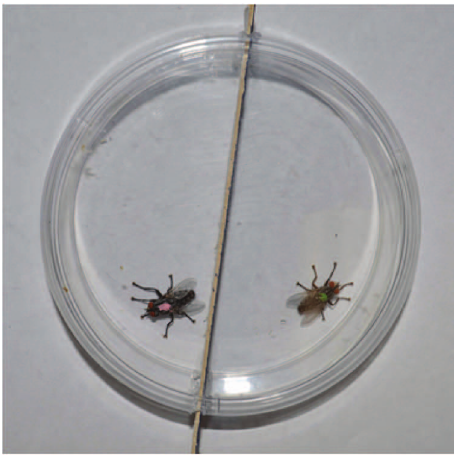
Figure 1. The experimental arena, viewed from above. Two male flies (each with a different color paint mark on the dorsal thorax) from the same age cohort were introduced to the arena, separated by a black partition. After 10 min, the partition was removed and observations began.